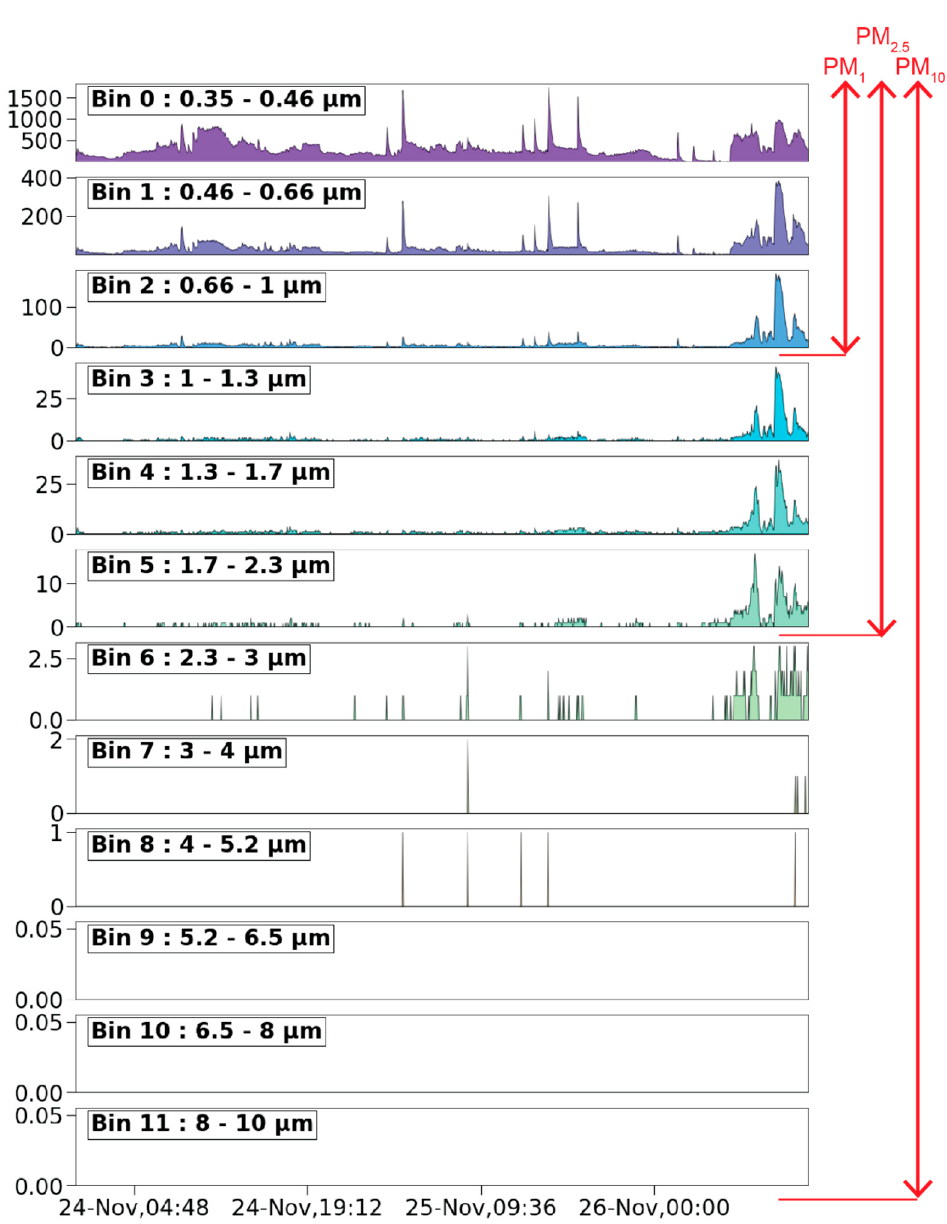
Figure 6. Number of particles in the first 12 size bins as detected by the OPC-N3 sensor over time during the same monitoring campaign as the measurements in Figure 5. The discrete size bins give an insight into the particle size distribution.